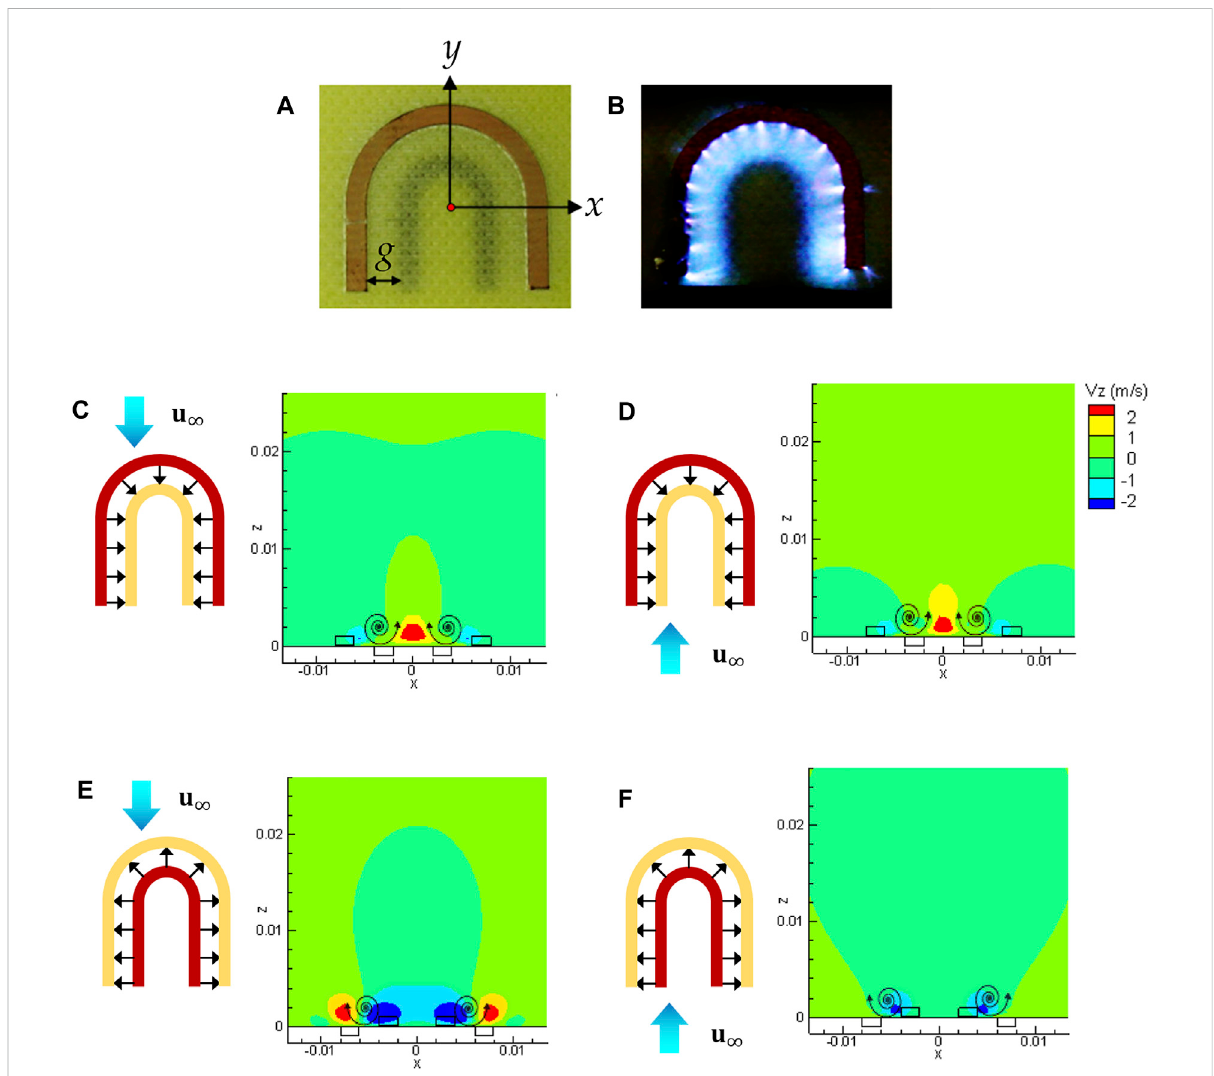
FIGURE 9 Horseshoe SDBD reactor (actuator). (A) Real-life example. (B) Plasma envelope. (C,D) Vortical structures depending on the direction of the freestream velocity when plasma forms inwards. (E,F) Vortical structures depending on the direction of the freestream velocity when plasma forms outwards. Concept and data taken from